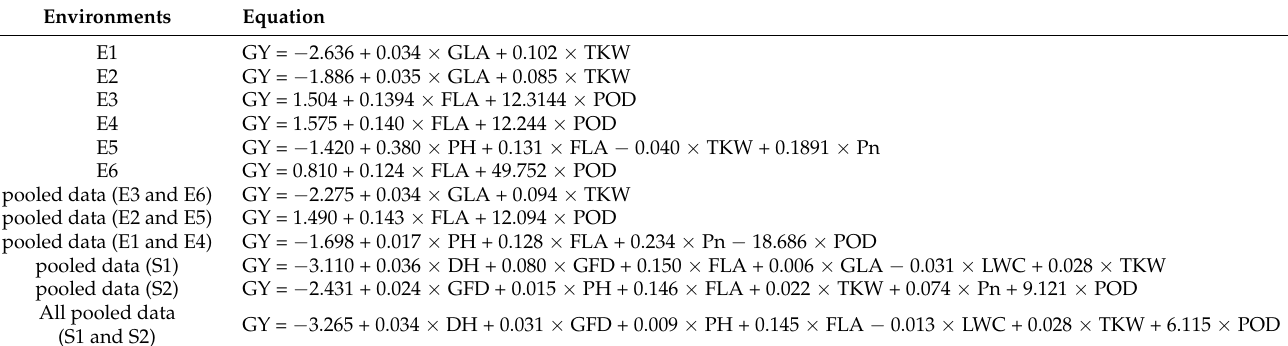
Table 4. Selection of the most influential traits for predicted grain yield (GY) based on stepwise multiple linear regression analysis.